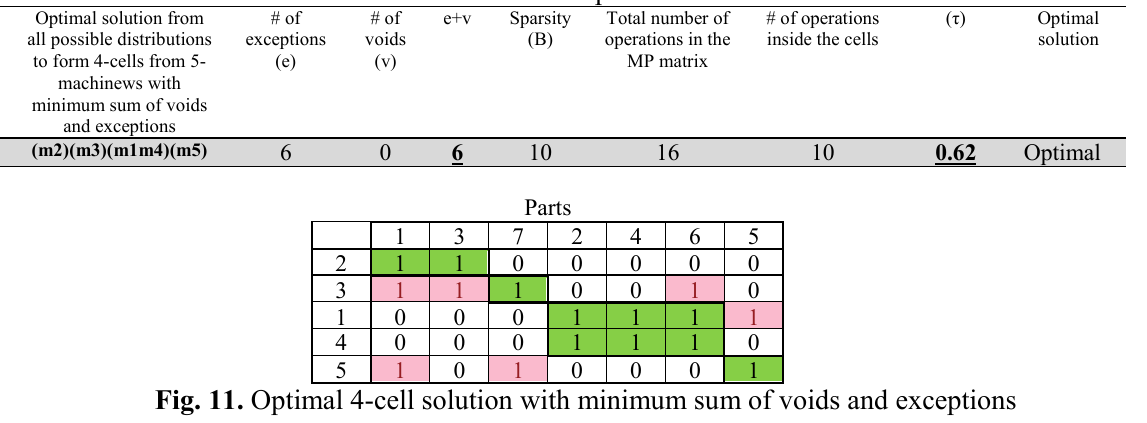
Optimal solution with minimum sum of voids and exceptions